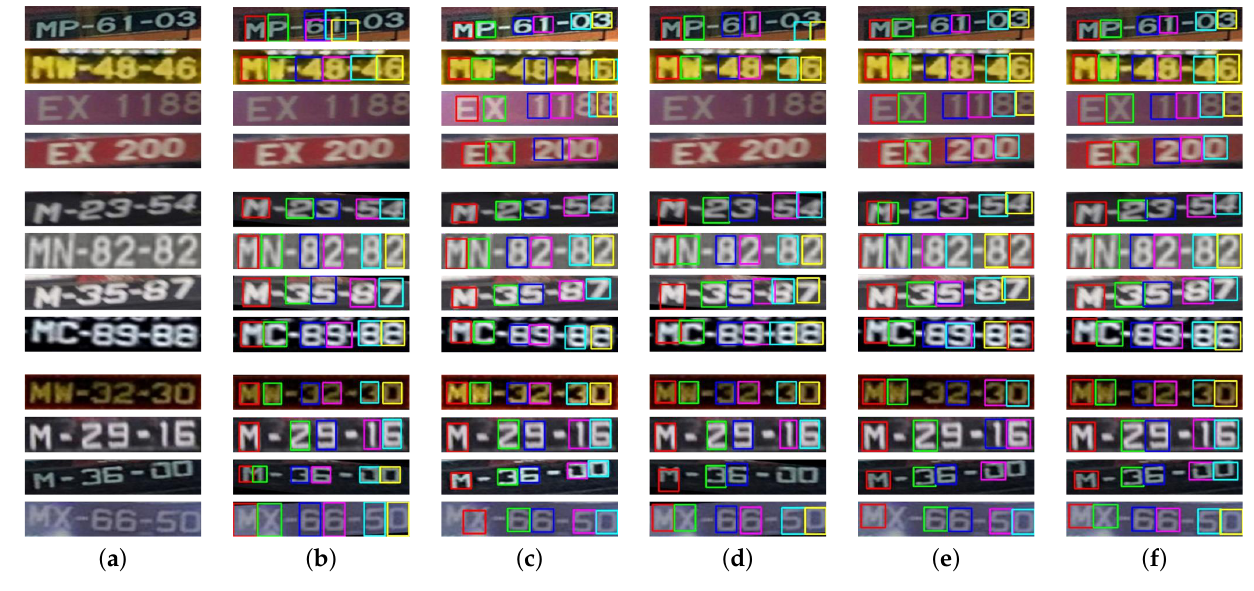
Figure 7. Some segmentation results of single-row license plates. ( a ) Input images. ( b ) Projection- based [13]. ( c ) MSER-based [17]. ( d ) CCA-based [19]. ( e ) ROI-based [33]. ( f ) Ours.